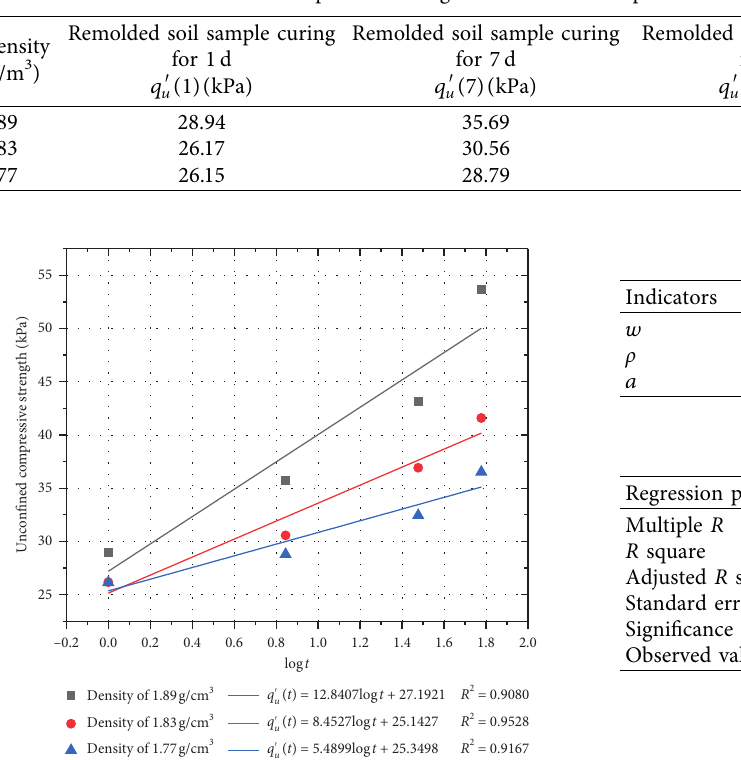
Table 4: Unconfined compressive strength of remolded samples with different densities at different curing times.